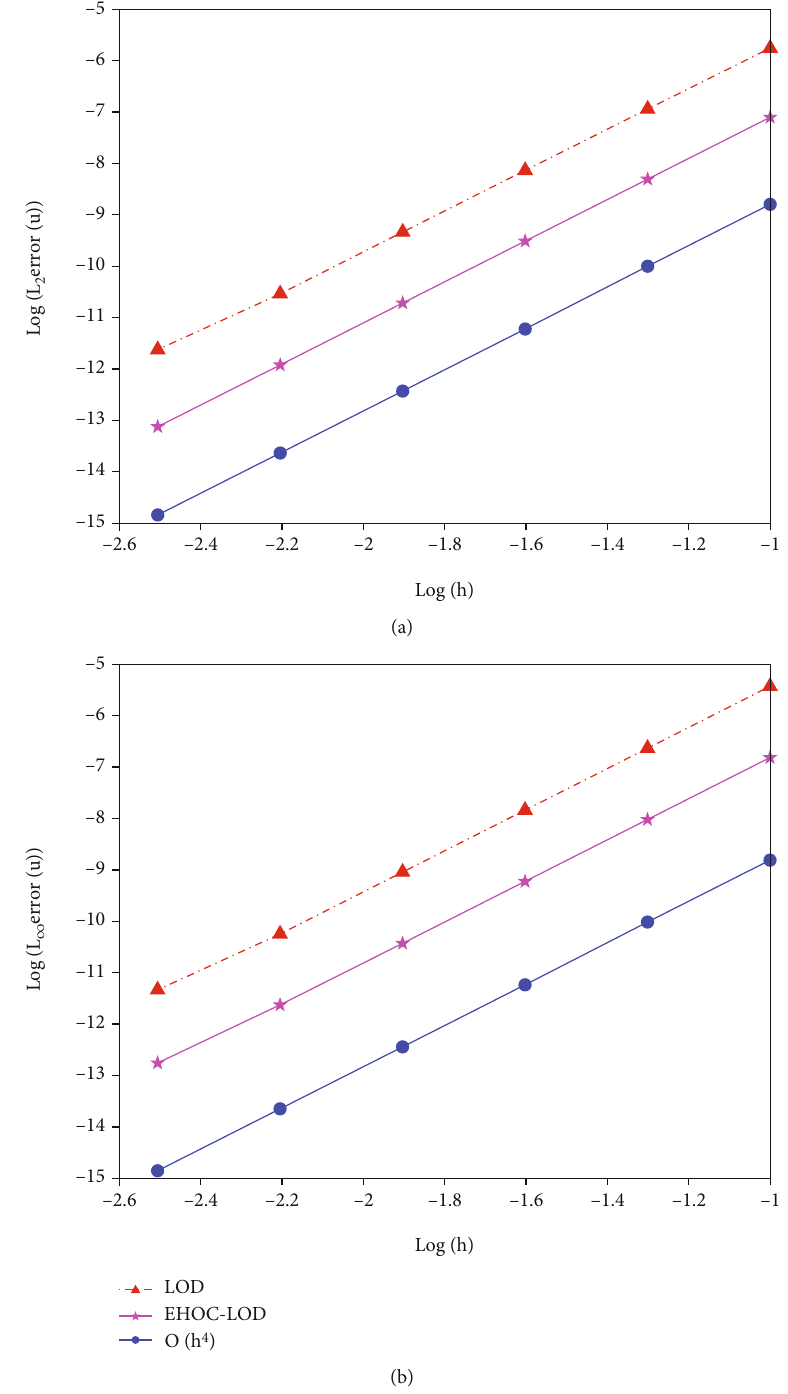
Figure 1: Log-log plots for the L